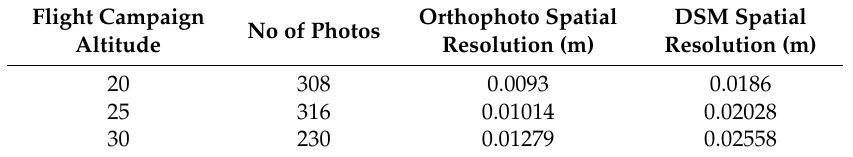
Table 1. UAV flight campaign characteristics and derived product resolution. DSM: digital surface model.